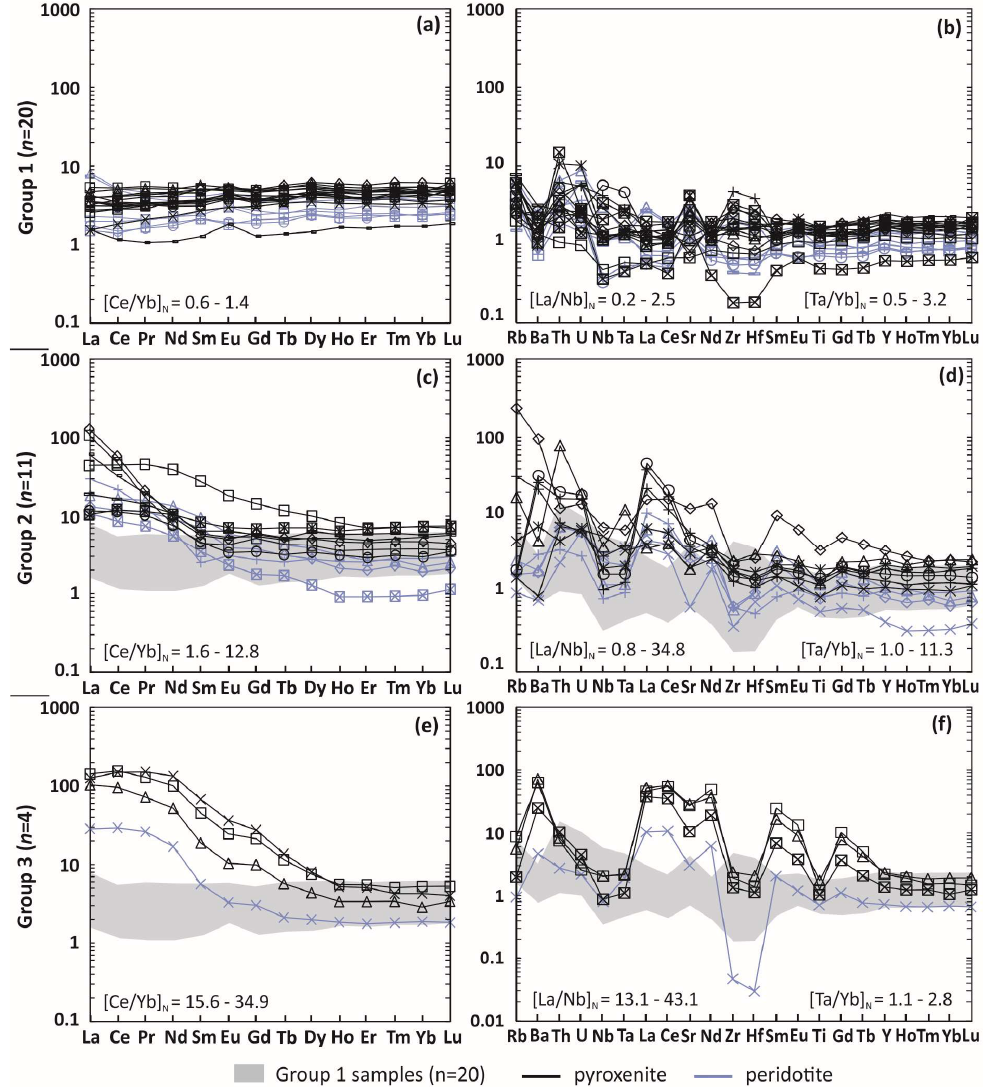
Figure 4. Chondrite-normalised Rare Earth Elements (REE) plots and primitive mantle-normalised trace-element plots for the group 1 ( a , b ), group 2 ( c , d ) and group 3 ( e , f ) ultramafic rocks from the Ben Strome Complex. Normalised values from McDonough and Sun [88]. Note scale change on ( f ).